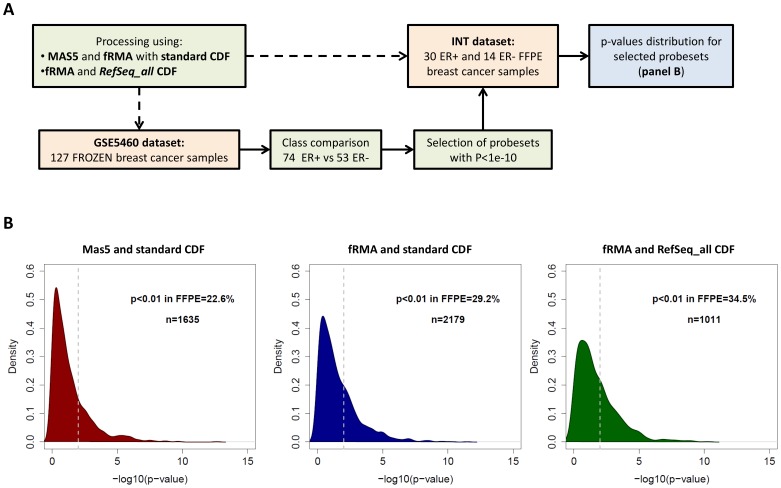
Correlation between frozen- (FFN) and FFPE-derived fold changes as a function of the processing procedure.Fold changes between ABC and GCB subgroups were computed in the Williams dataset [15] for three representative processing pipelines, separately for frozen- and FFPE-derived data. Commonly DE probesets are in dark yellow, probesets only DE in frozen data are in blue and those only DE in FFPE data are in dark red.